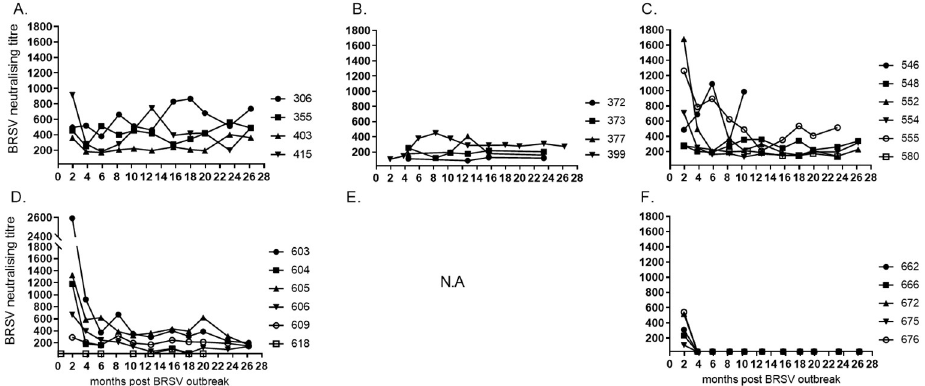
Fig 2. Kinetics of BRSV-neutralising serum antibody titres in cattle of different age and production status. Cattle were (A) 23–30 months old ( < 6 months gestation), (B) 24–26 months old ( > 6.5 months gestation), (C) 7–11 months old, (D) 4–5 months old, (E) 2–3 months old, not analysed (N.A), or (F) born during or just after a BRSV outbreak in January 2016 (month 0). Limit of detection in the virus neturalising assay: titre